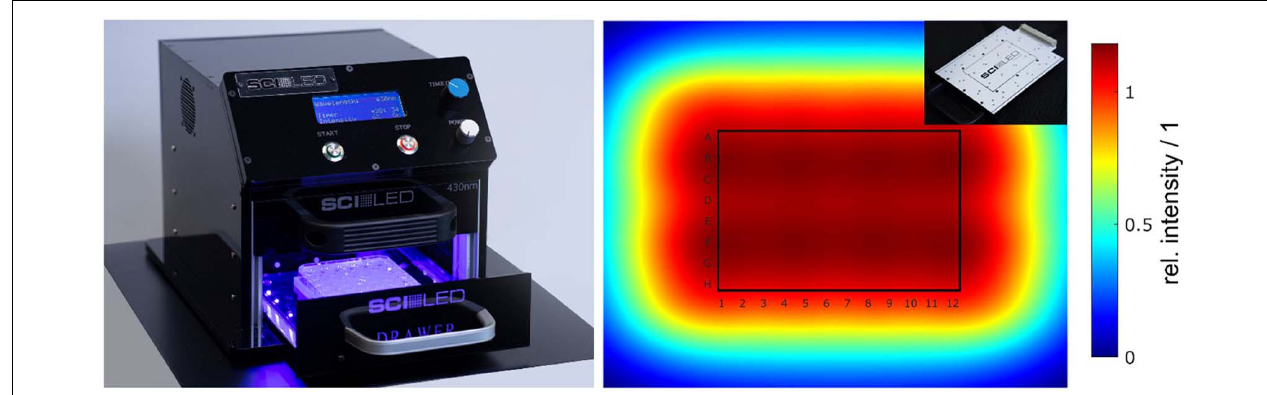
FIGURE 1 | (Color online) Irradiation setup (SciLED) and simulated irradiance. The irradiation experiments were performed with a light-emitting diode (LED)-based setup (left). Due to its design, the LED modules can be easily exchanged to enable different wavelength settings (insert, top right). With the integrated user interface, the radiant exposure can be set by a timer and an intensity controller. The arrangement of the 6 × 4 LED array on the modules was optimized to achieve a uniform irradiance at the sample plane. Optical simulations of the irradiance showed a uniform distribution with a theoretical variation of less than 0.1% over the entire area of 96-well plates